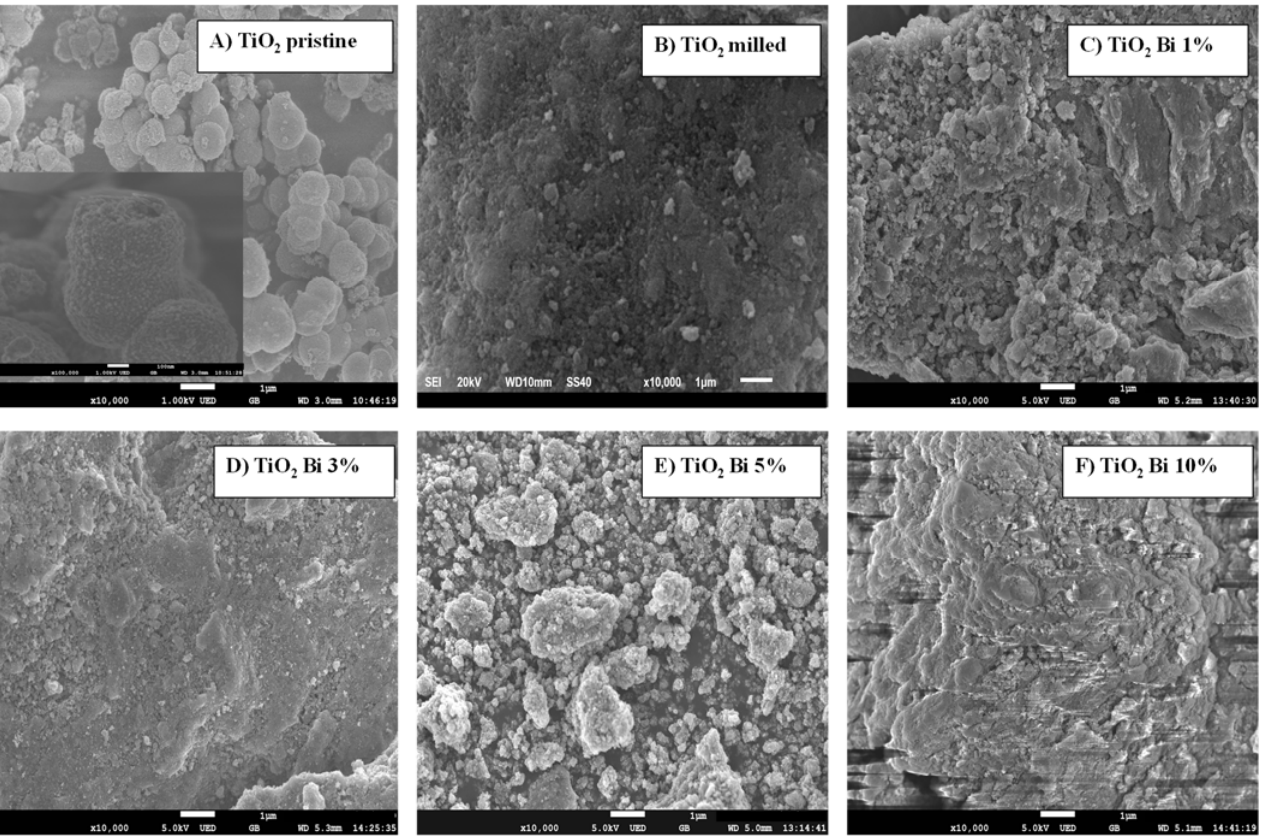
Figure 3. SEM images at 10,000 X of the pristine TiO 2 ( A ), milled TiO 2 ( B ), and Bi ‐ doped TiO 2 sam